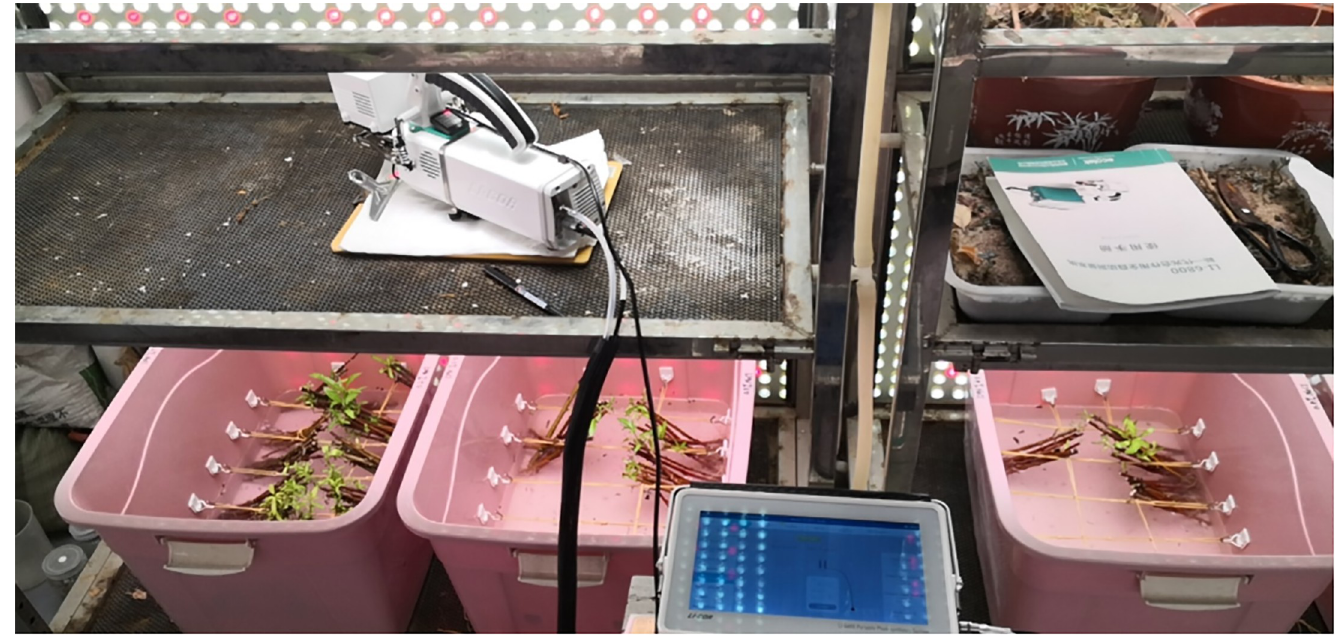
Fig 1. Experimental scenes of the effects of salt stress on Salix alba